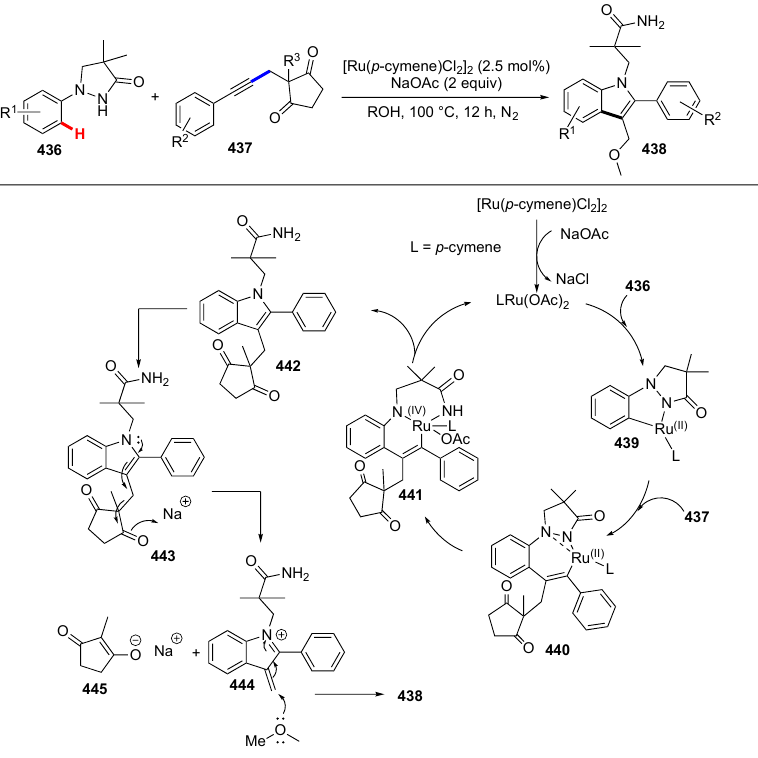
Scheme 56. Ru-catalyzed synthesis of 3-(alkoxyalkyl)-1 H